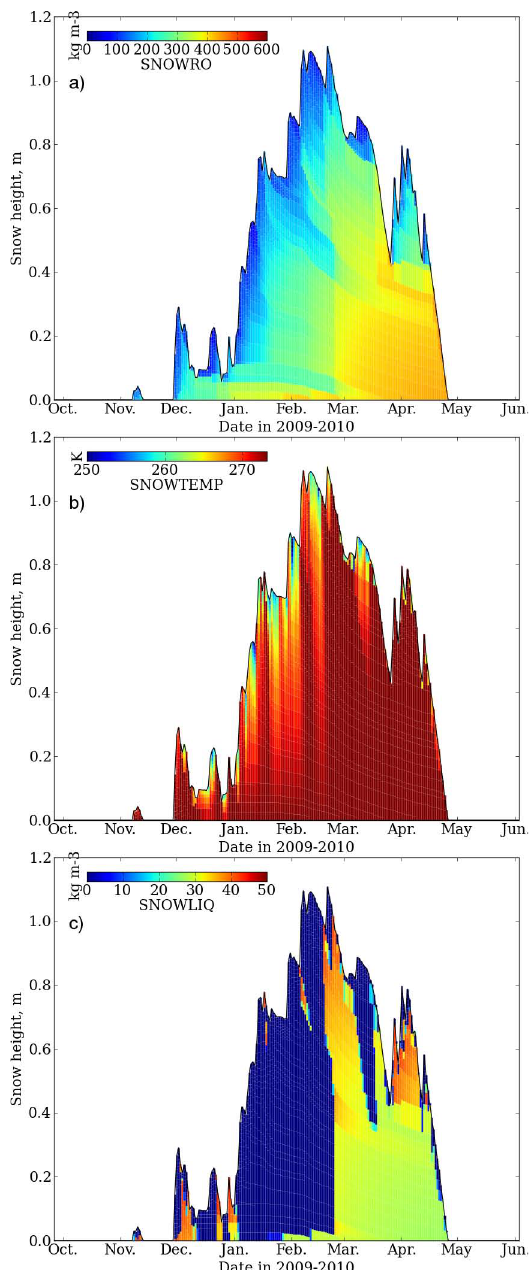
Fig. 5. Example of visualization of the time series of snowpack profile properties simulated by the snowpack scheme Crocus in SURFEX. The simulation used is the year 2009–2010 of simula- tion from the model run carried out at Col de Porte, France (see Sect. 5.1 for details). The data represented here are (a) snow den- sity (kgm − 3 ), (b) snow temperature (K), and (c) snow liquid water content (kgm − 3